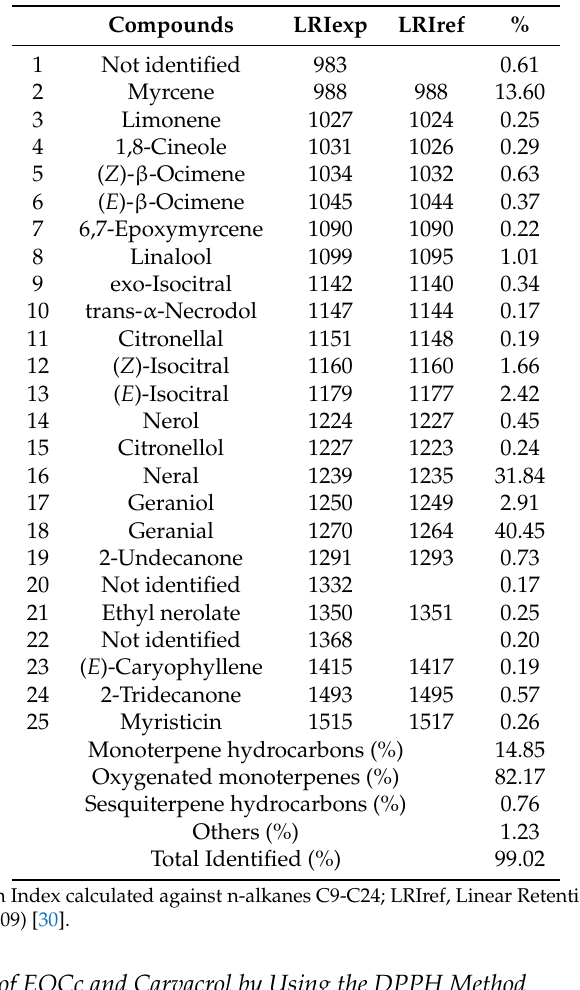
Table 1. Chemical composition of the essential oil of C. citratus determined by GC-MS.